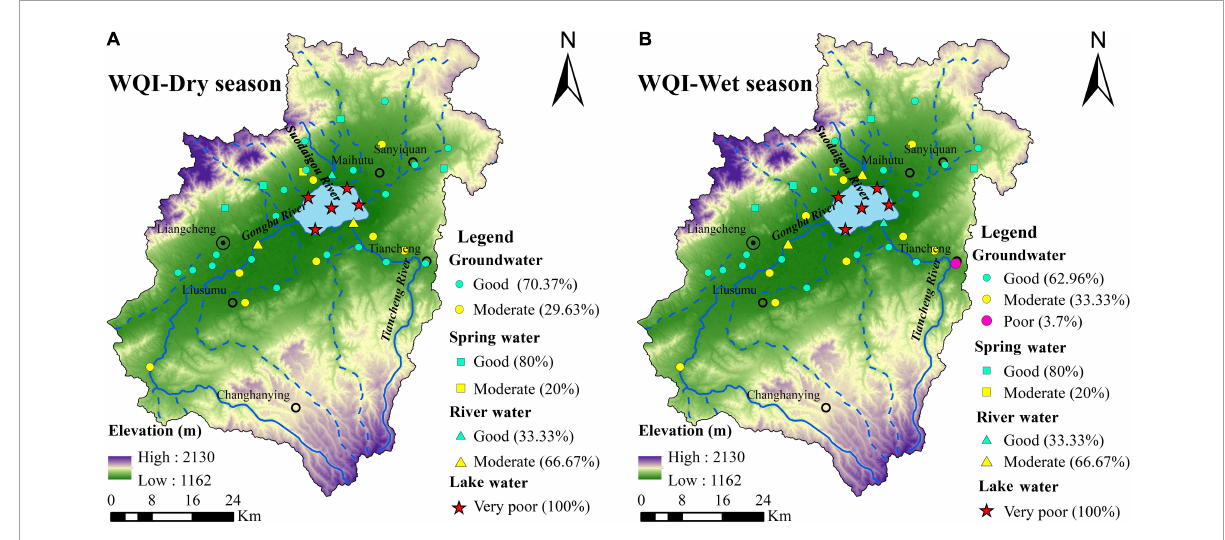
FIGURE4 Spatial distribution of water quality assessment results in dry (A) and wet (B) seasons in the Daihai Lake